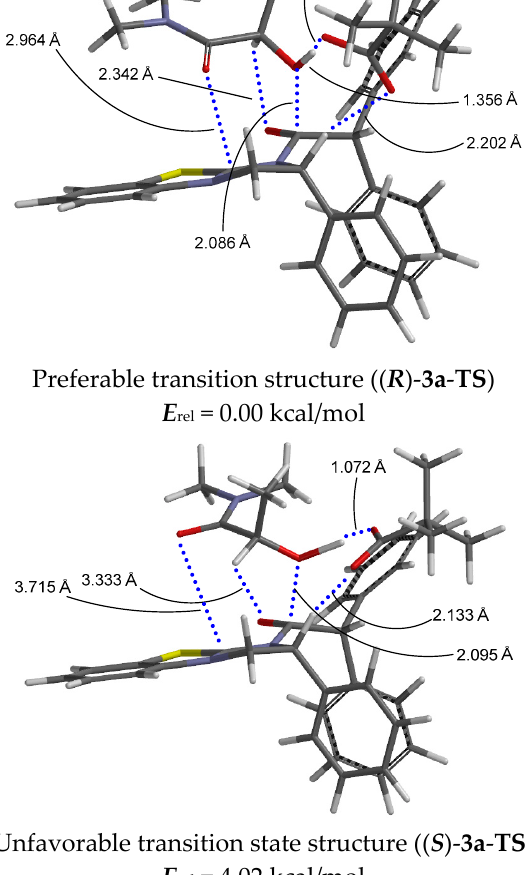
Figure 1. Three-dimensional structures of the calculated transition states (( R )- 3a - TS and ( S )- 3a - TS